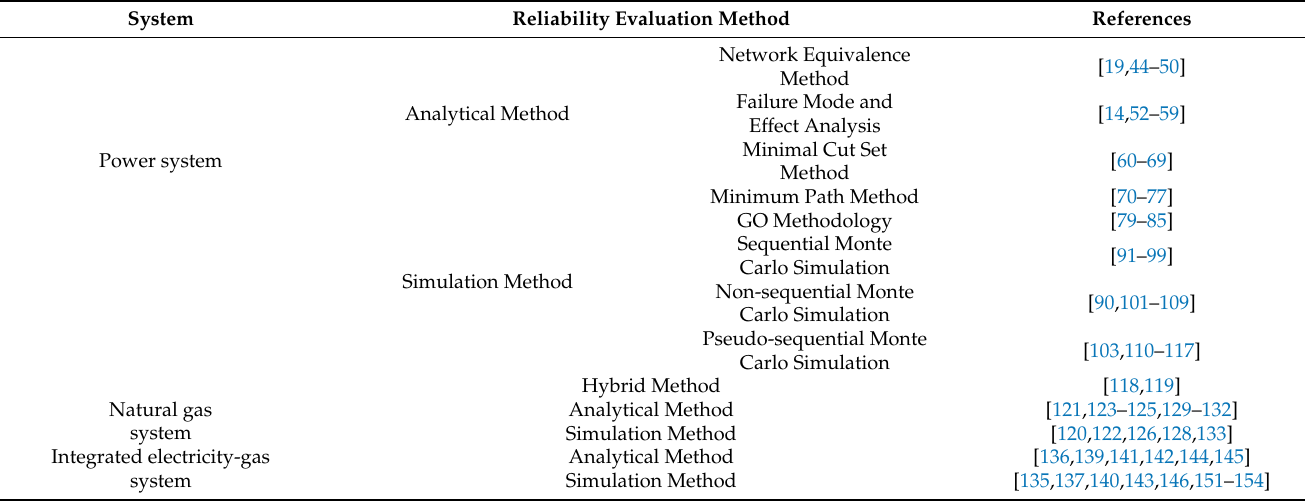
Table 2. Reliability assessment method reference